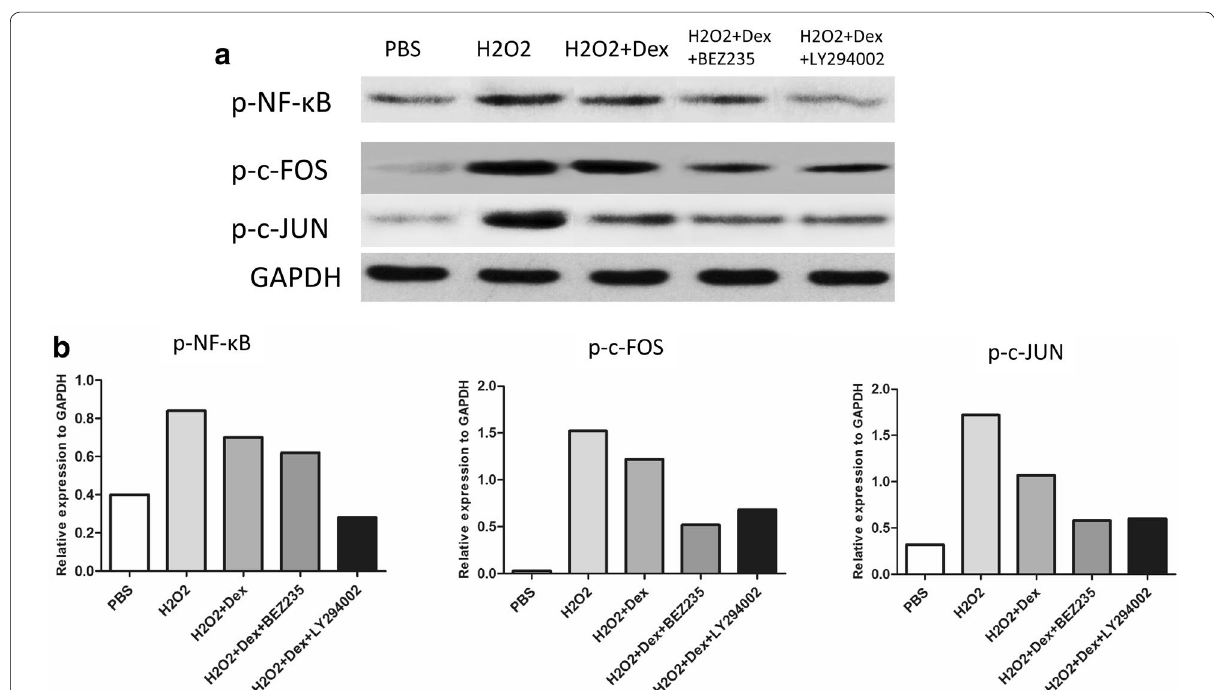
Fig. 7 Effect of the PI3K inhibitor on the phosphorylation of nuclear signaling transcription factors in the H 2 O 2 -U937 cell model. a The expression of nuclear signaling transcription factors (p-NF-κB, p-c-FOS, and p-c-JUN) in the H 2 O 2 -U937 cell model was analyzed by western blotting. b Quantitative densitometric analysis of immunoreactive bands showed that p-NF-κB was most strongly inhibited by the combination of LY294002 and dexamethasone. p-c-FOS and p-c-JUN were most strongly inhibited by the combination of either BEZ235 or LY294002 with dexamethasone. Representative data from at least 3 independent experiments are shown (*p < 0.05; **p < 0.01, ns: nonsignificant. Each experiment was repeated at least three